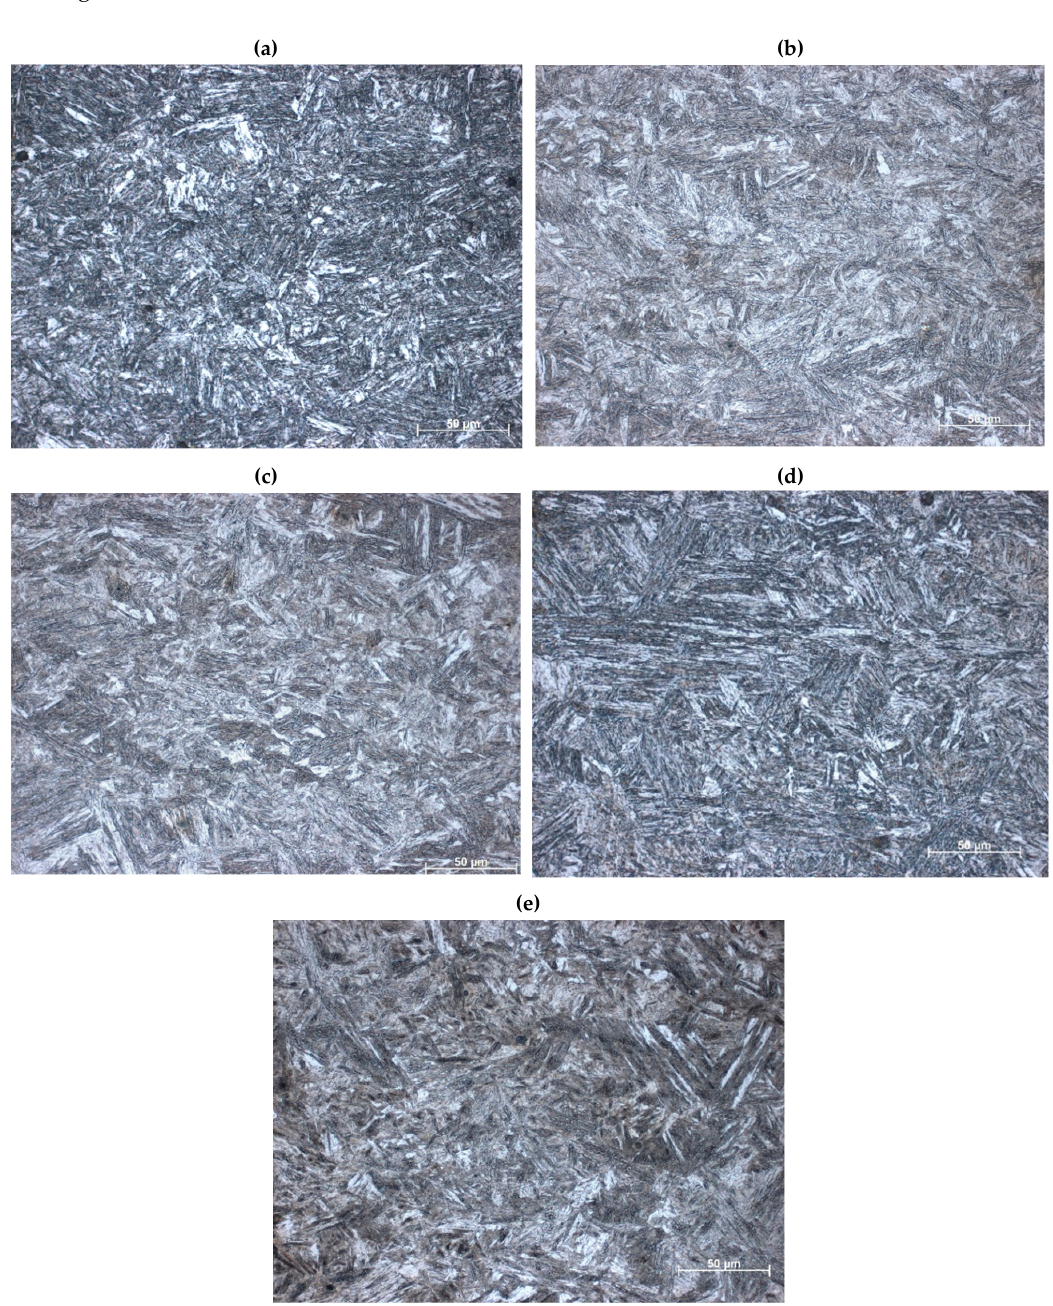
Figure 5. Optical micrographs of the investigated steel: (a) delivery state; deformed at: (b ) 20 ° C, (c) 60 ° C, ( d ) 100 °C, and (e) 140 ° C.